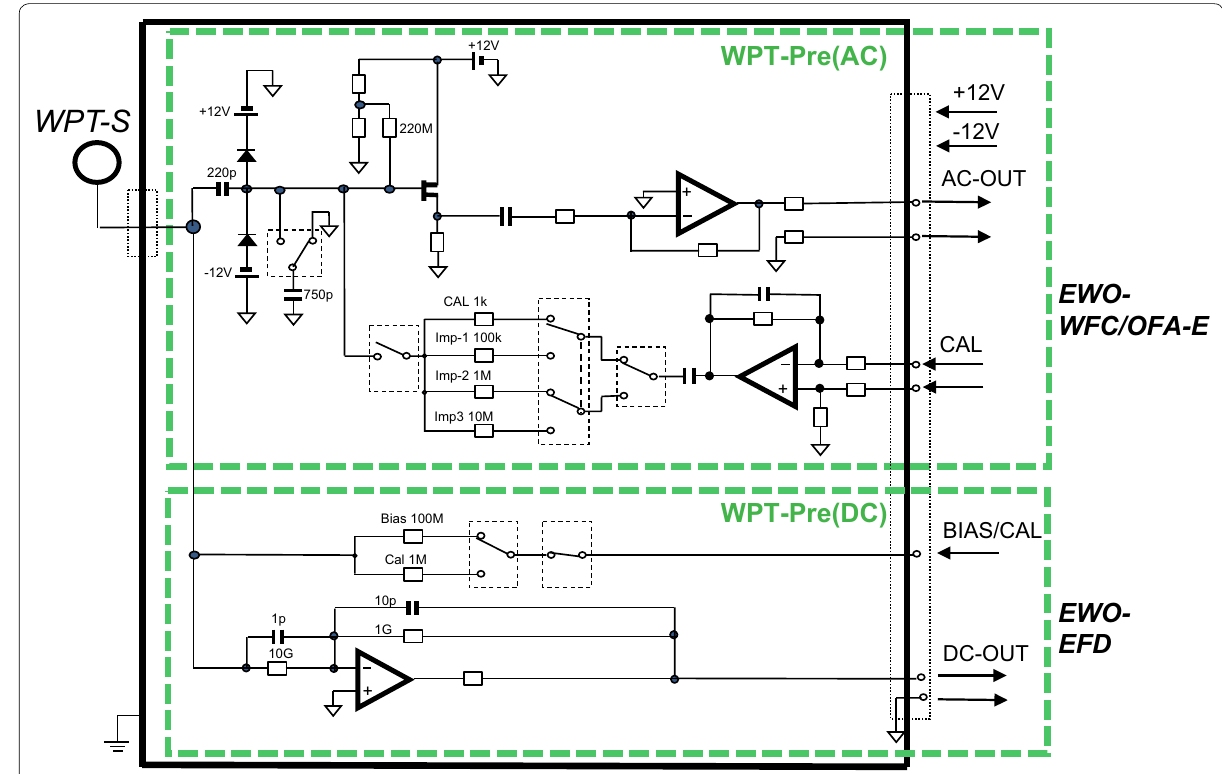
Fig. 4 Block diagram of